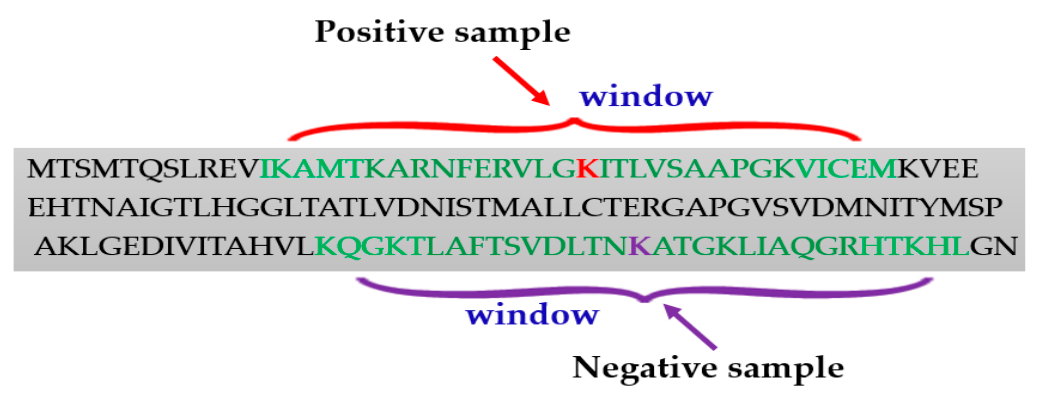
Figure 2. Window selection procedure for generating positive and negative samples.